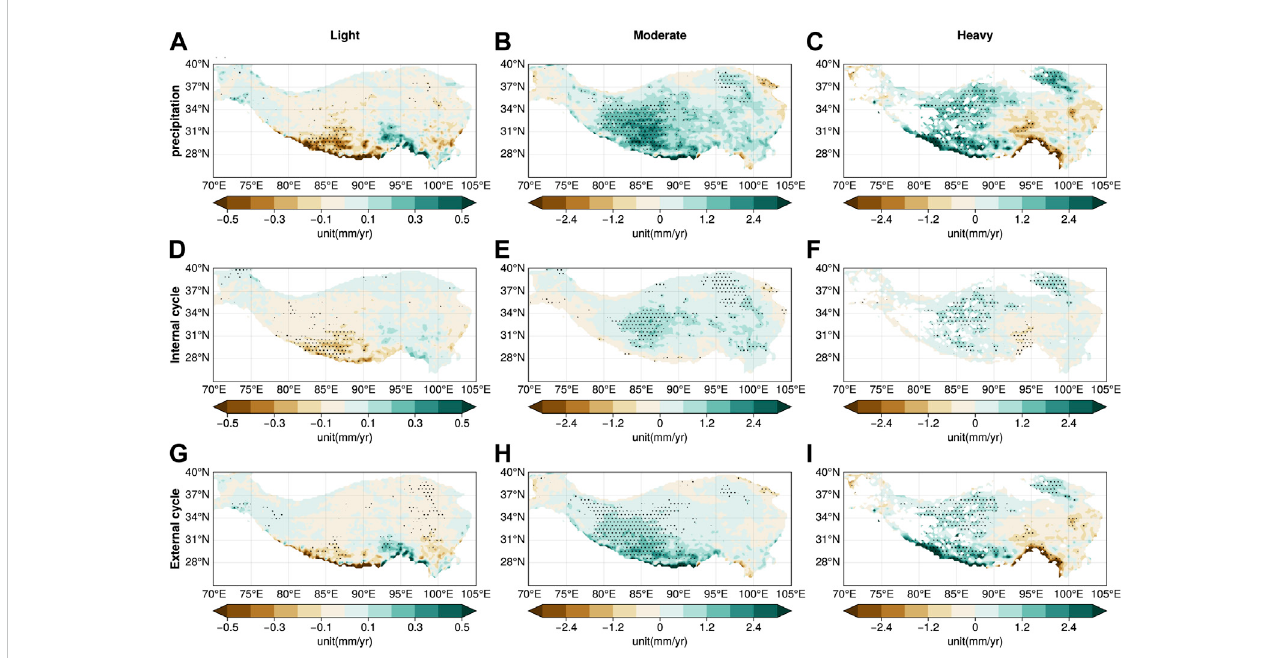
FIGURE 4 Thetrendmapoftotalprecipitation (A – C) ,precipitationassociatedwithinternal (D – F) andexternal (G – I) cyclesforlight(leftcolumn),moderate(middle column) and heavy precipitation (right column) over the TP. The dotted areas indicate statistical signi fi cance exceeding